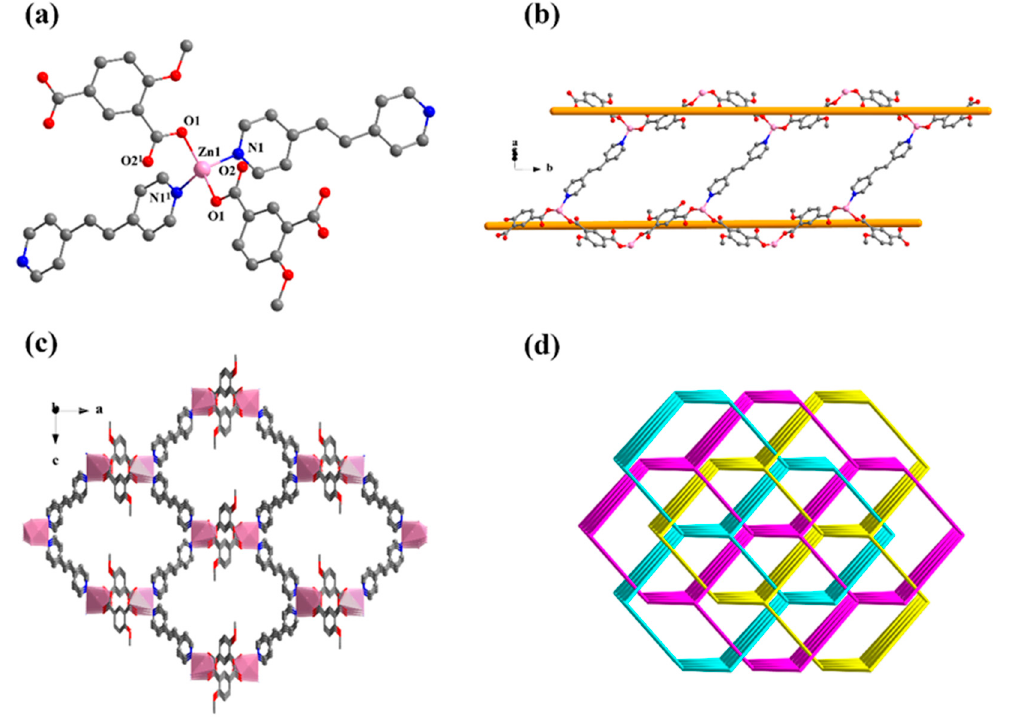
Figure 4. ( a ) The coordination environment of Zn1. ( b ) The left-handed and right-handed chains of compound 3 , {[Zn(MIPA)(bpe)] · H 2 O} n . The a, b and c represent a axis, b axis and c axis, respectively.